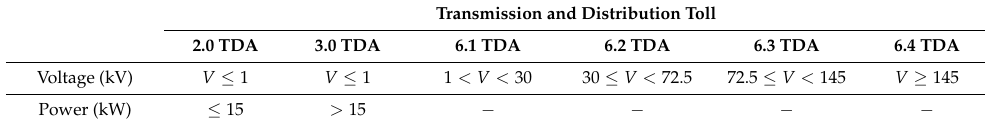
Table 2. Voltage and power limits corresponding to each transmission and distribution toll.